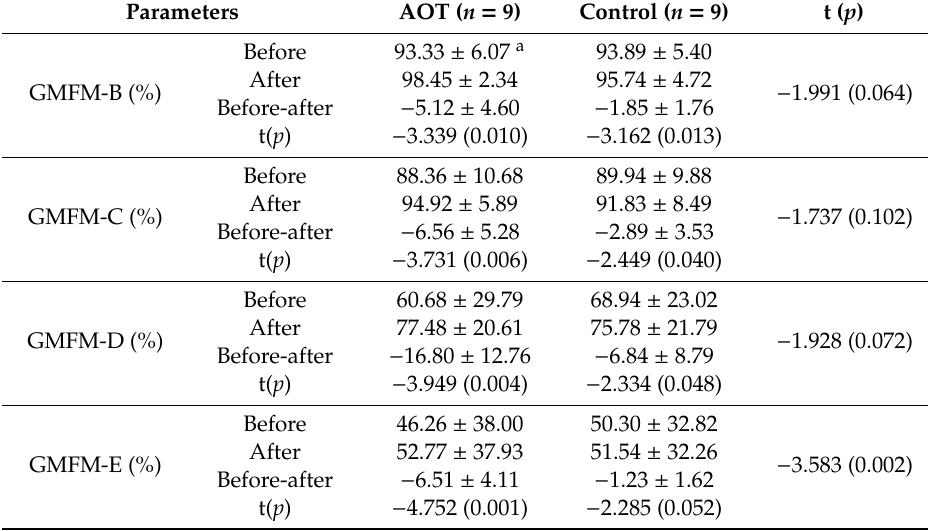
Table 4. Di ff erences in gross motor function ( N = 18).